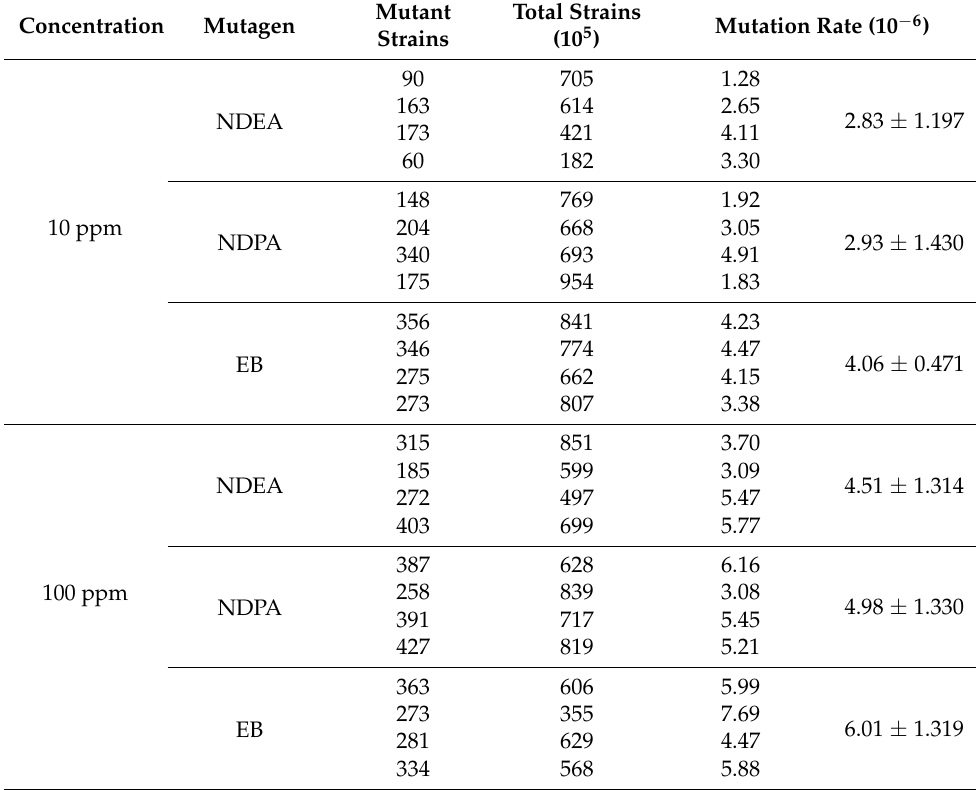
Table 5. Mutation rate of rpsL induced by mutagens in